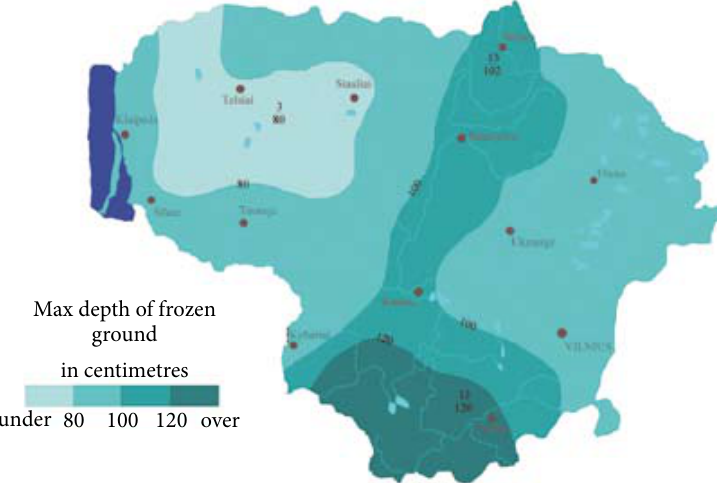
fig. 3. Max and min depth of frozen ground in centimetres (Juknevičiūtė, Laurinavičius 2008):